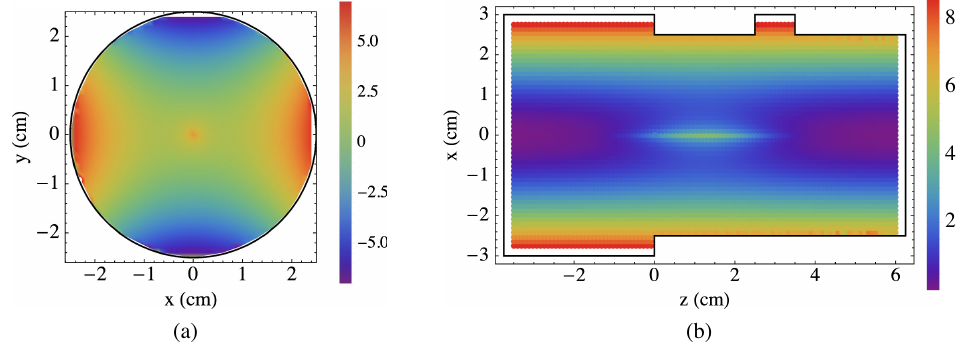
FIG. 11. Plots of the electrostatic potential (kV) in a cross section of the narrow beam pipe (a) and along the longitudinal shot of the beam pipe (b) with the Gaussian beam for 10 times the number of